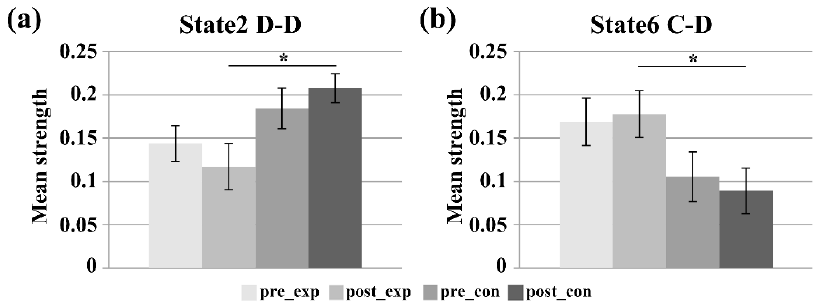
Figure 5. The mean strength of the sub-networks showing significant group/training differences. ( a ) The D-D subnetwork in state 2, and ( b ) the C-D subnetwork in state 6. Error bars represent the standard error (* p < 0.05).